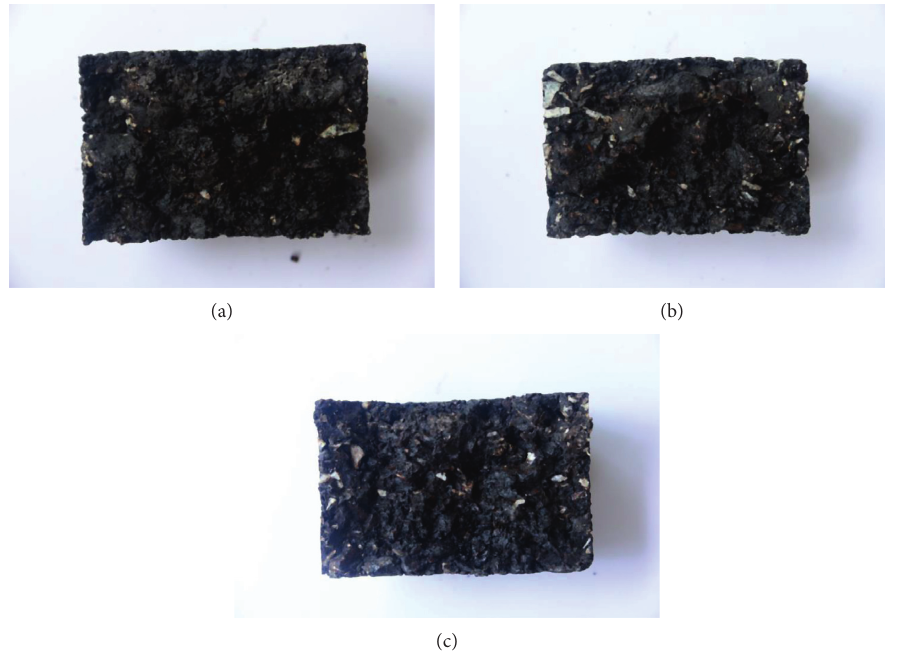
Figure 8: Post median filter-sample specimen of WMA. (a) Dry-WP170, (b) 1FT-WO170, (c) 3FT-WP170.